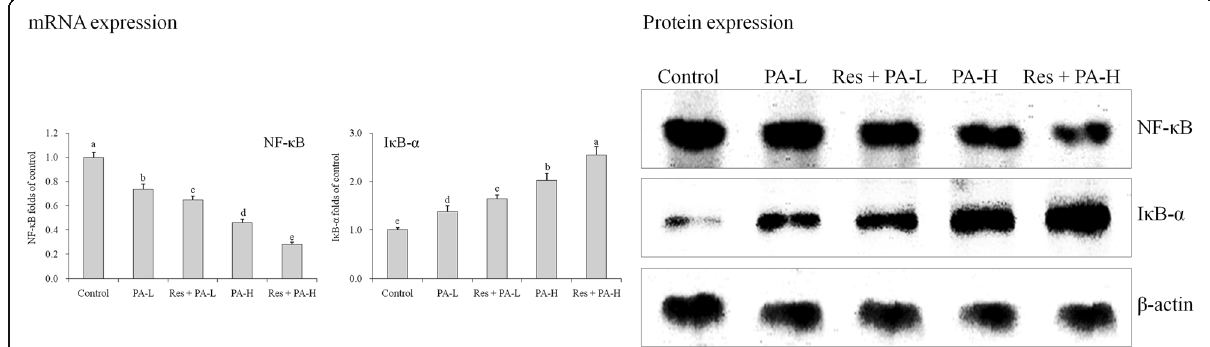
Fig. 9 The mRNA and protein expression of NF- κ B and I κ B- α in HepG2 human liver cancer cells. a-e Mean values with different letters over the bars are significantly different (P < 0.05) according to Dunnett ’ s post-hoc test. PA-L: 5 μ g/mL of paclitaxel; Res + PA-L: 10 μ g/mL of resveratrol +5 μ g/mL of paclitaxel; PA-H: 10 μ g/mL of paclitaxel; Res + PA-H: 10 μ g/mL of resveratrol +10 μ g/mL of